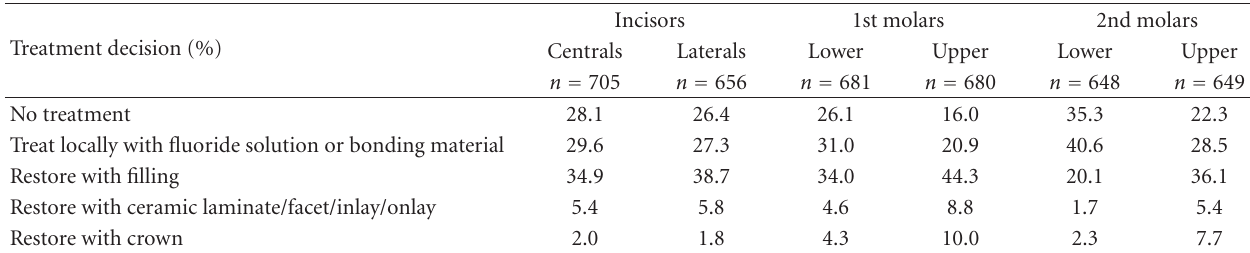
Table 2: The frequency (%) of dentists’ general choice of treatment and/or type of restorative material in the patient case. n : number of dentists responding to each question.